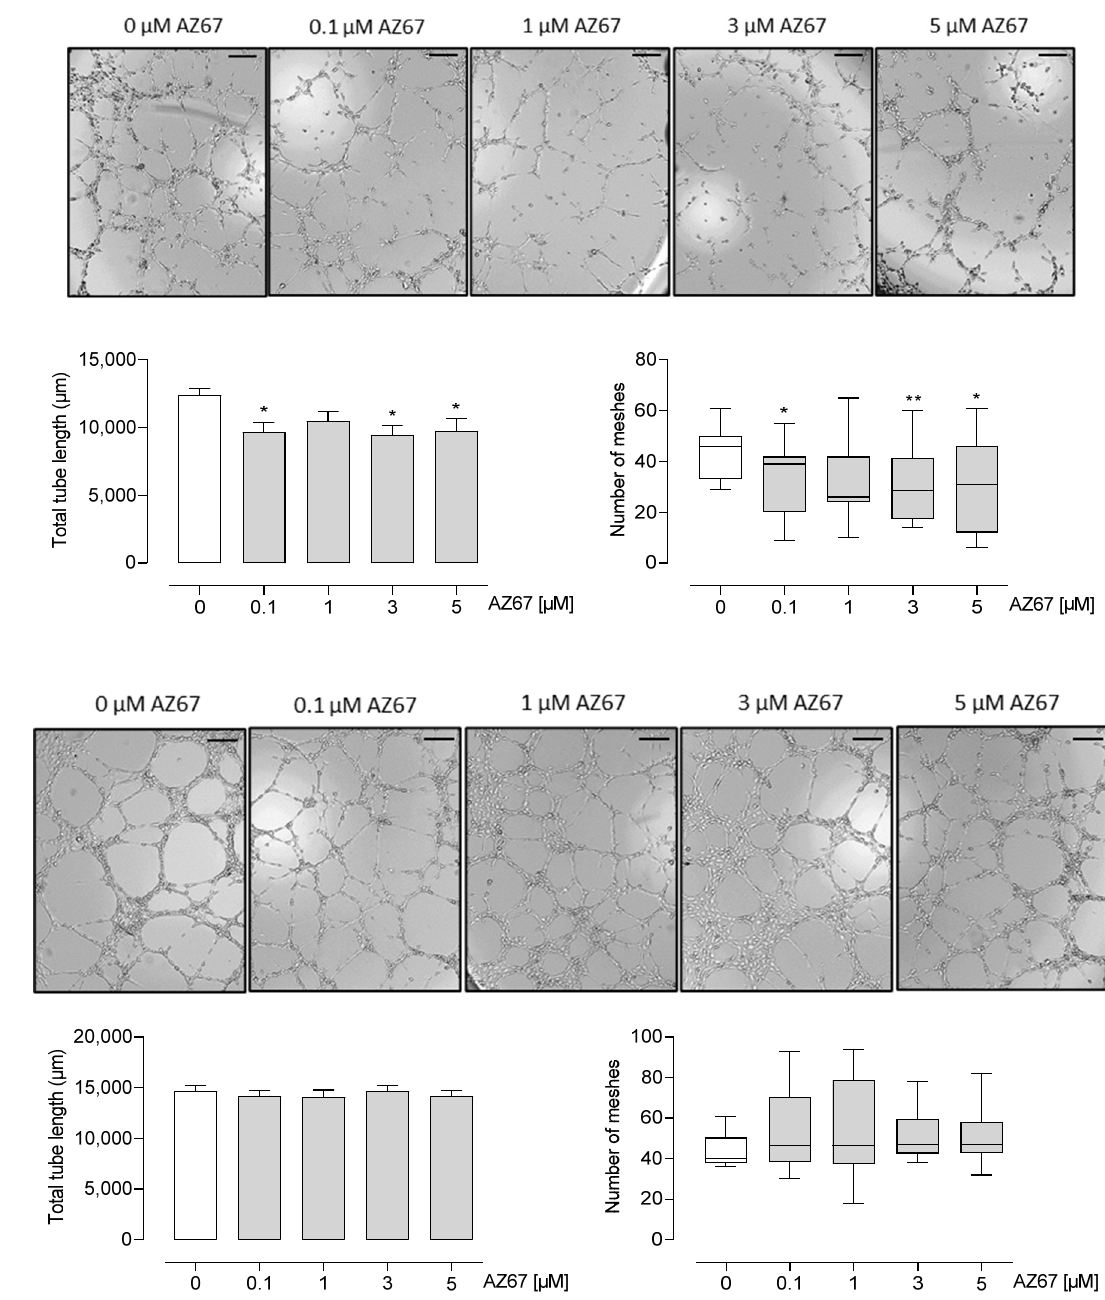
Figure 5. AZ67 inhibits tube and mesh formation of HAOEC upon TNF- α ( A ) but not DMOG ( B ) pre-treatment. ECs were pre-treated with 20 ng/mL hTNF- α , or 1 mM DMOG for 24 h. Cells were seeded onto a Matrigel matrix and treated with different concentrations of AZ67 (0.1, 1, 3, 5 µ M) supplemented with hTNF- α , or DMOG for 8-9 h. Representative images of tube and mesh-like structures were captured using an inverted microscope. Scale bar = 200 µ m. Tube length: * p < 0.05 vs. 0 µ M (ANOVA, followed by Dunnett test); Number of meshes * p < 0.05, ** p < 0.01 vs. 0 µ M, Kruskal–Wallis test, followed by Mann–Whitney test.